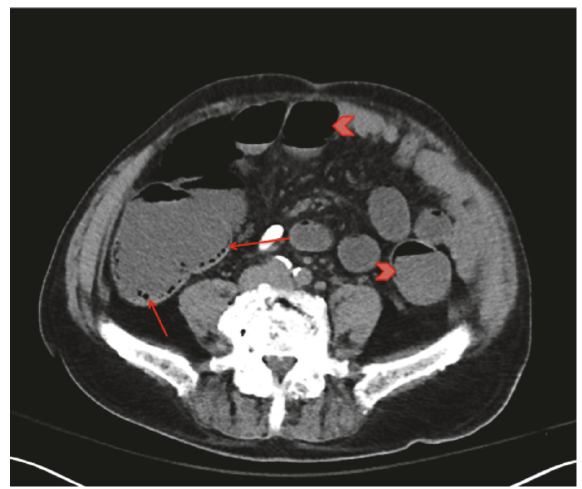
Figure 1: CT scan notable for colonic distention with submucosal and intraluminal gas (arrow), distended fluid-filled distal small bowel loops (arrowhead).